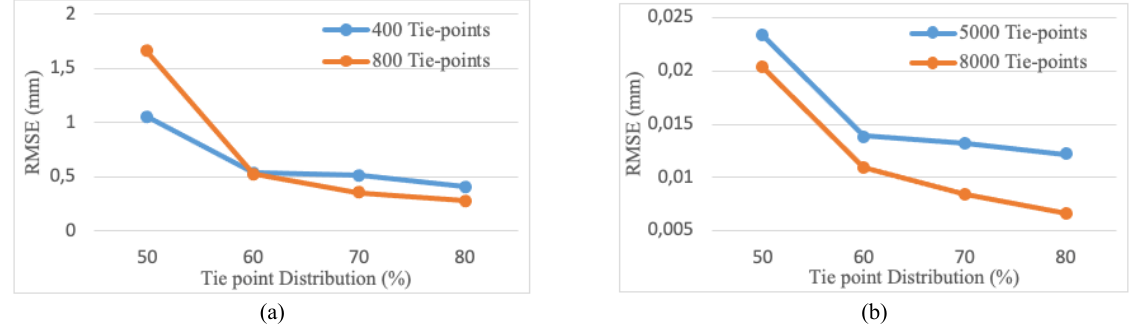
Figure 8 . RMSE of 3D points in the distribution analysis. Closed block with 24 (a) and 48 (b) images.